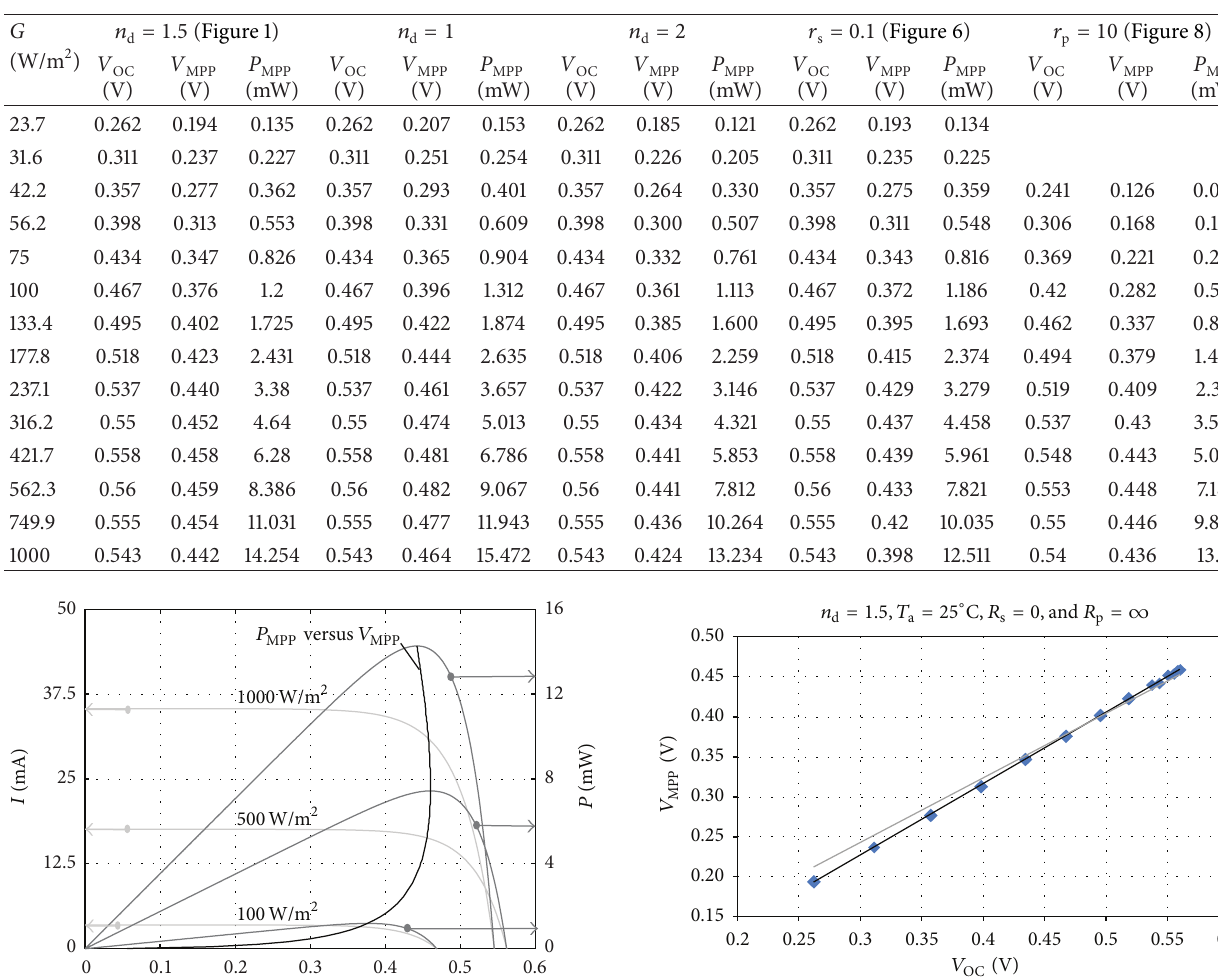
Table 1: Computed V parameters of the PV cell model.